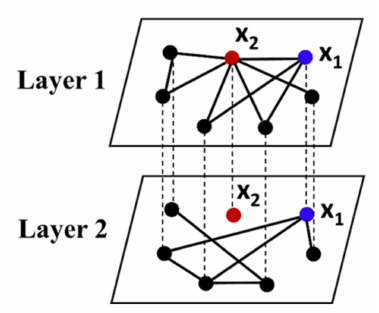
Figure 3. Diagram of the entropy of the multiplex degree. Node x 1 and node x 2 in the network correspond to a class of nodes with maximum and minimum entropy of the multiplex